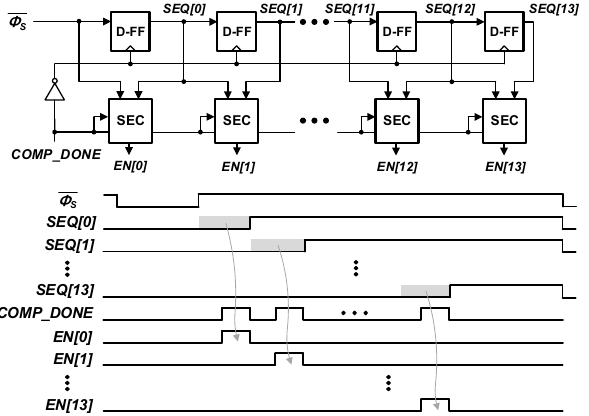
Figure 11. The block and timing diagram of the asynchronous SAR logic.